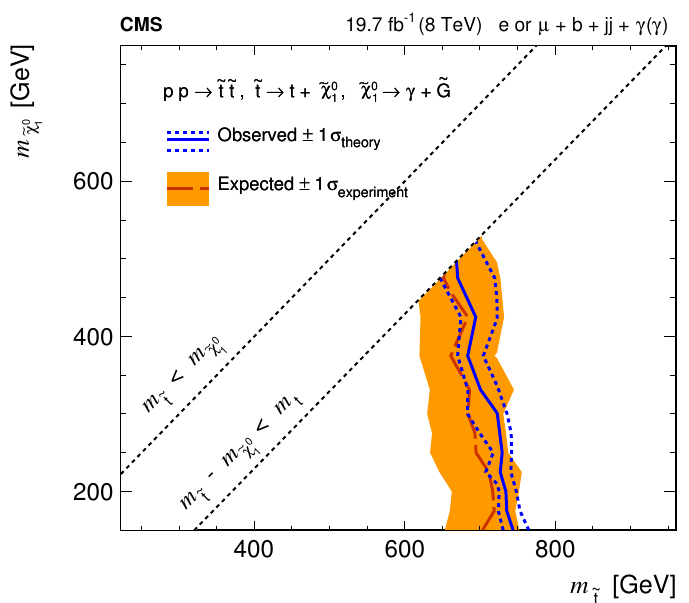
Figure 6 . Observed and expected mean exclusions at the 95% CL in the top squark and bino mass plane, and their ranges of uncertainties given by the contours at the 68% CL. The region to the left of the contour for m -m < m t is excluded by this e t e (cid:31) 0 1